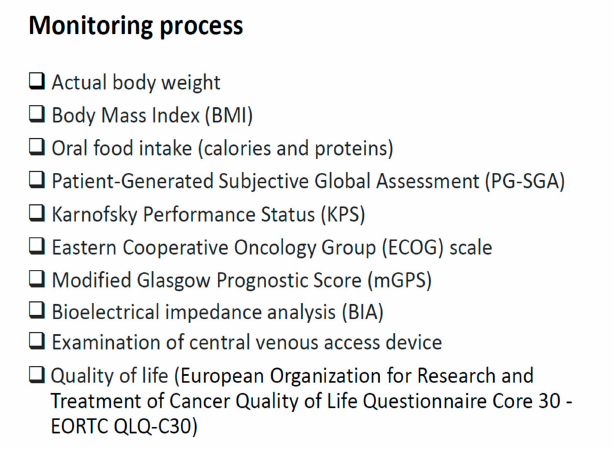
Figure 1. Parameters and indicators to monitor the response to Home Parenteral Nutrition in cancer